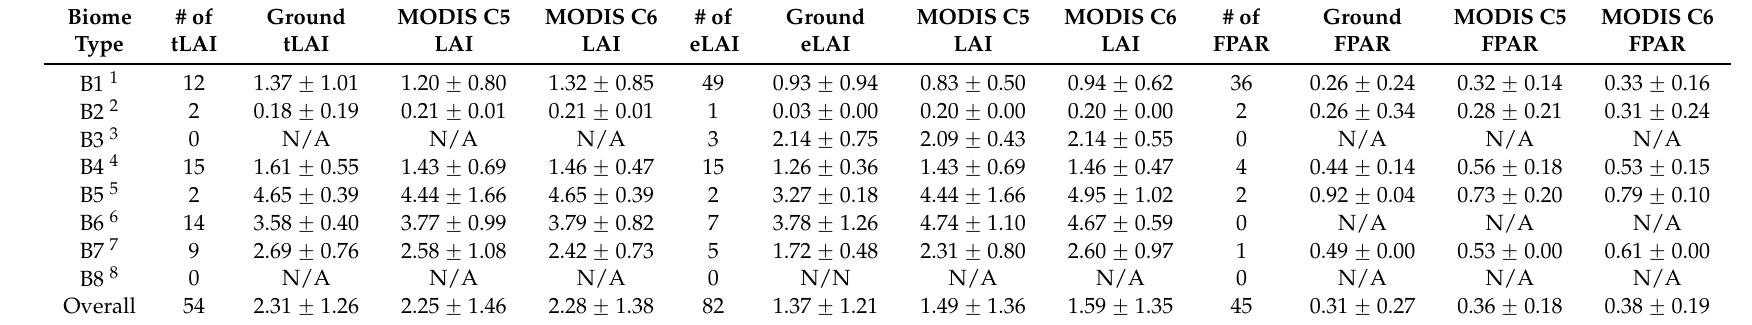
Table 3. Biome-specific information of ground measurements after pre-selection. The numbers of ground measurements of tLAI, eLAI and FPAR for each biome are listed. The mean values and standard deviations of both ground measurements and retrievals from the C5 and C6 products are also provided (mean value ˘ standard